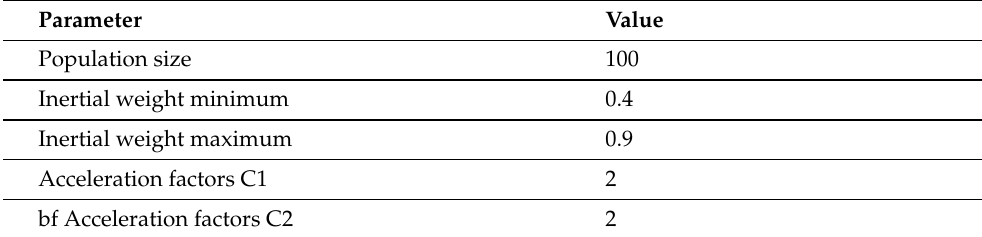
Table 3. Parameters Used for